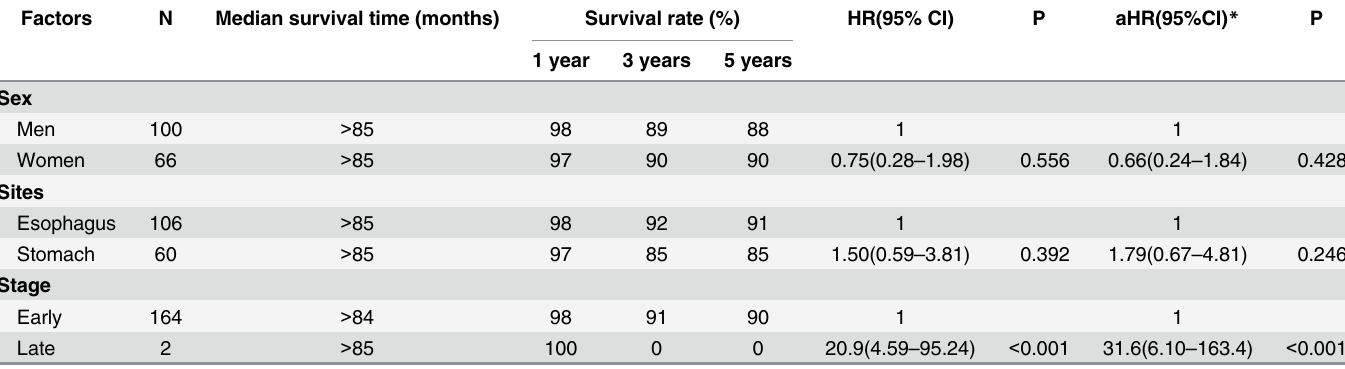
Table 4. Survival analysis on cancer patients detected in the endoscopic screening